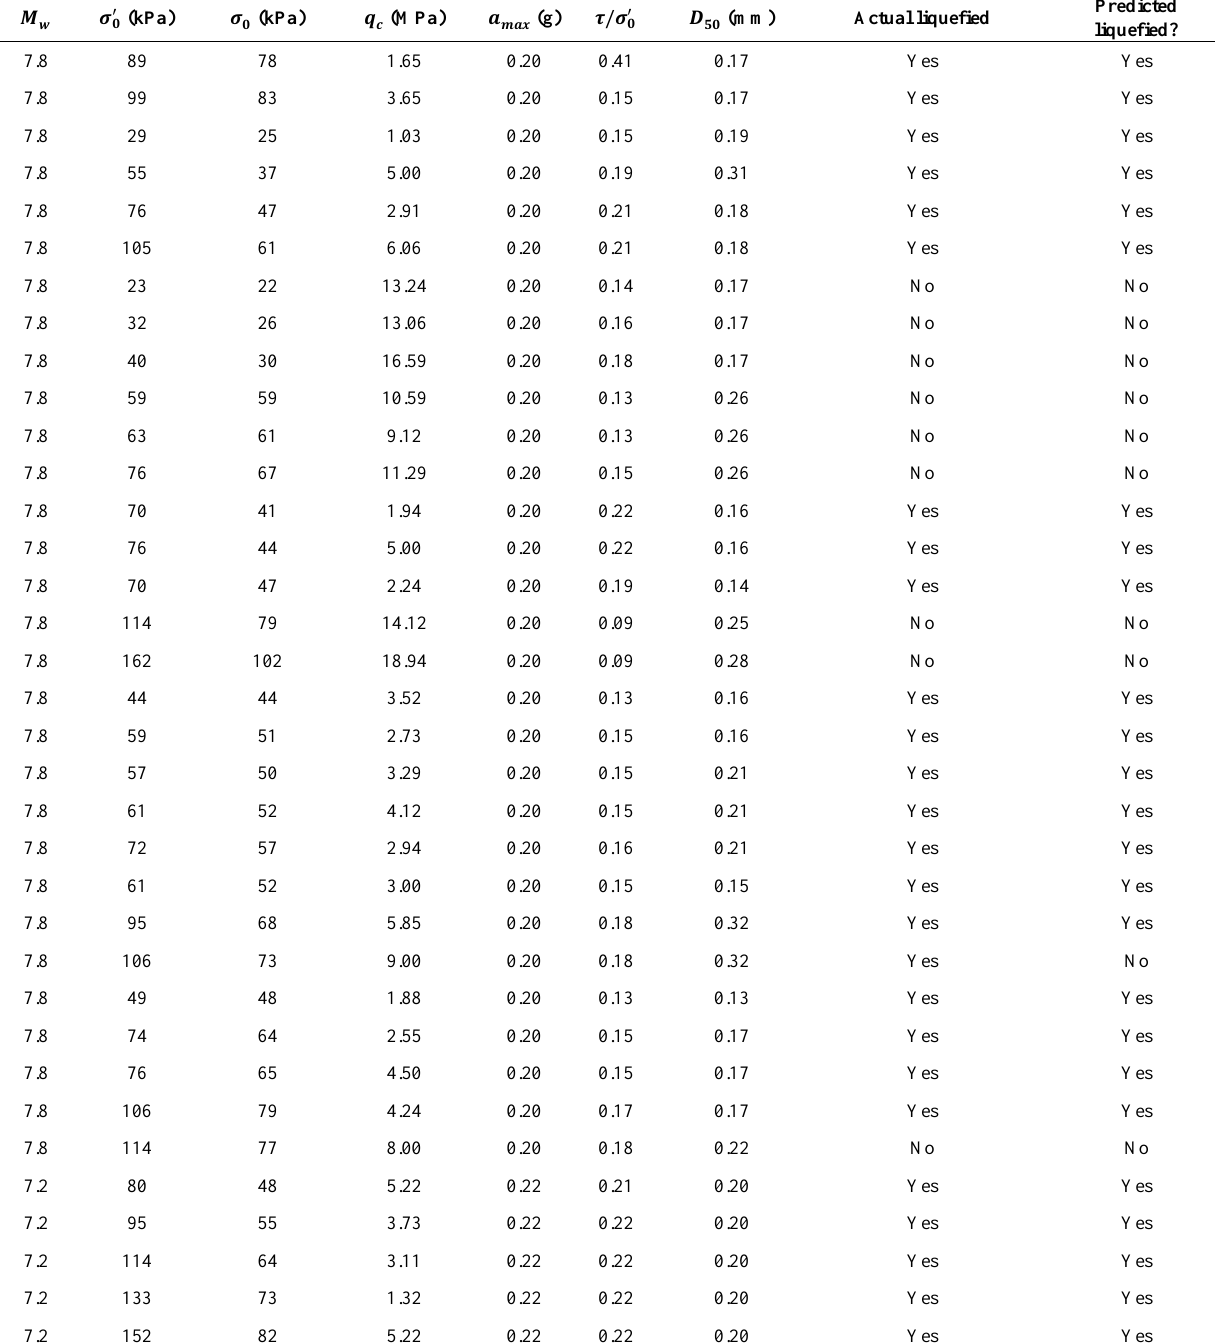
Table 3. Performance of C4.5 for testing dataset.